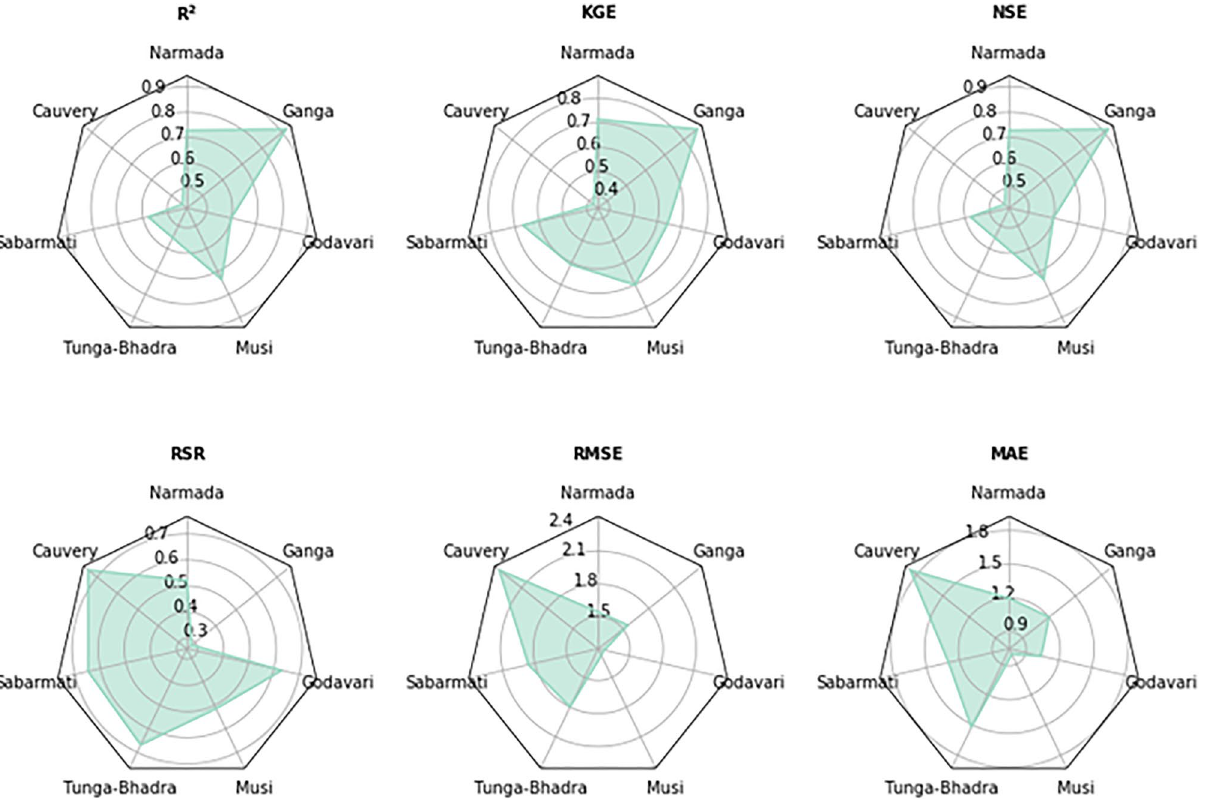
Figure 3. The representation of R 2 , KGE, NSE, RSR, RMSE, and MAE values in the form of a Radar plot for seven catchments for the kNN-LSTM model during the testing